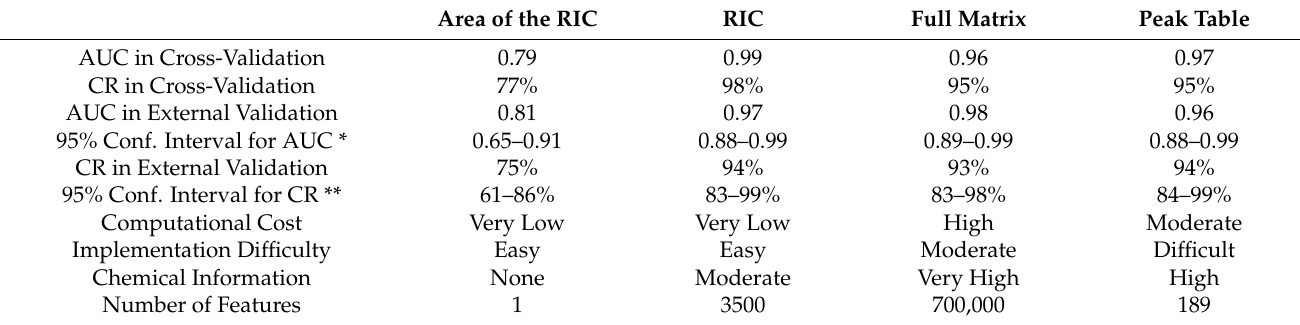
Table 1. Comparison of the performance for the different feature extraction methods. * AUC confidence Interval calculated using a parametric Gaussian approximation for the predictive output. ** A 95% confidence interval has been computed according to the binomial distribution, taking into account the finite number of samples used for the estimation of the proportion. Area of the RIC RIC Full Matrix Peak Table AUC in